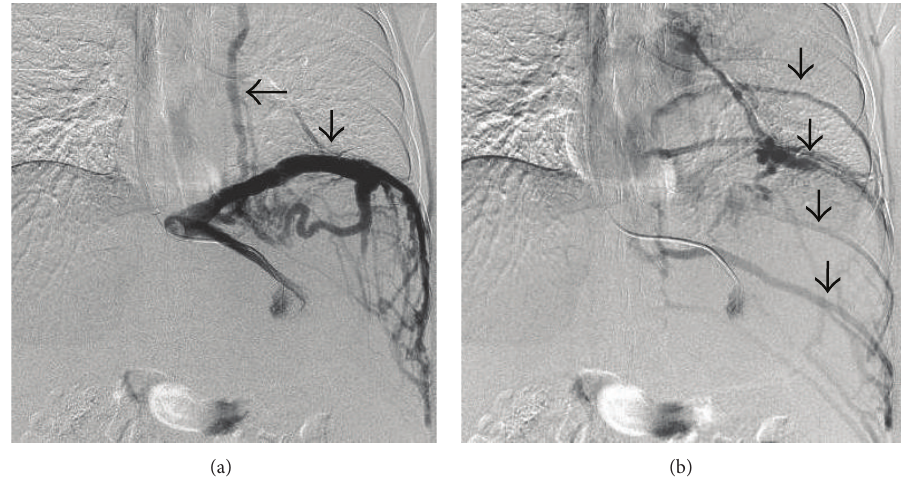
Figure 30: Angiogram performed via a catheter inserted in the left hepatic vein demonstrates drainage through the inferior phrenic vein (vertical arrow in (a)) and pericardiophrenic collateral (horizontal arrow) with delayed opacification of the intercostal veins as well (vertical arrows in